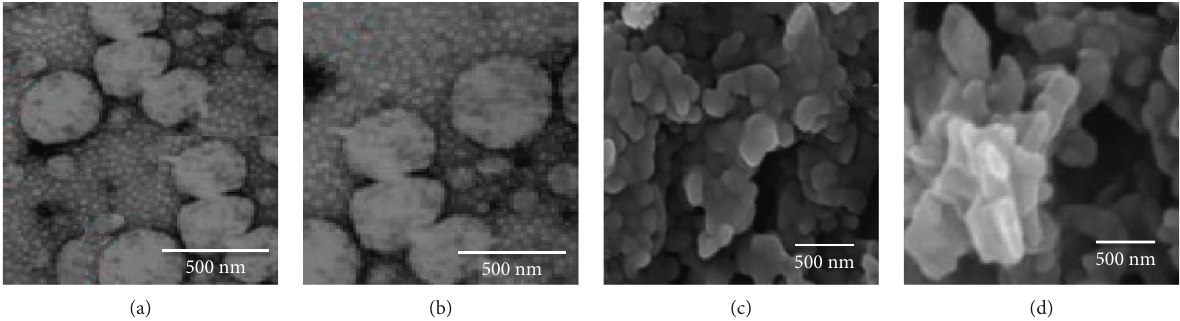
Figure 3: TEM and SEM image of synthesized nanostructures. (a) TEM image of soy protein nanoparticles (SPNs), (b) TEM image of vancomycin-loaded soy protein nanoparticles (vancomycin-SPNs), (c) SEM image of SPNs, and (d) SEM image of vancomycin-SPNs. Spherical and oval shapes of the drug-free SPNs and vancomycin-SPNs in TEM images. Similar shapes for soy protein nanoparticles and vancomycin-loaded soy protein nanoparticles in SEM images. Table 1: Characteristics of size and zeta potential of free SPNs and vancomycin-SPNs. Nanoparticles Size (nm) SPNs